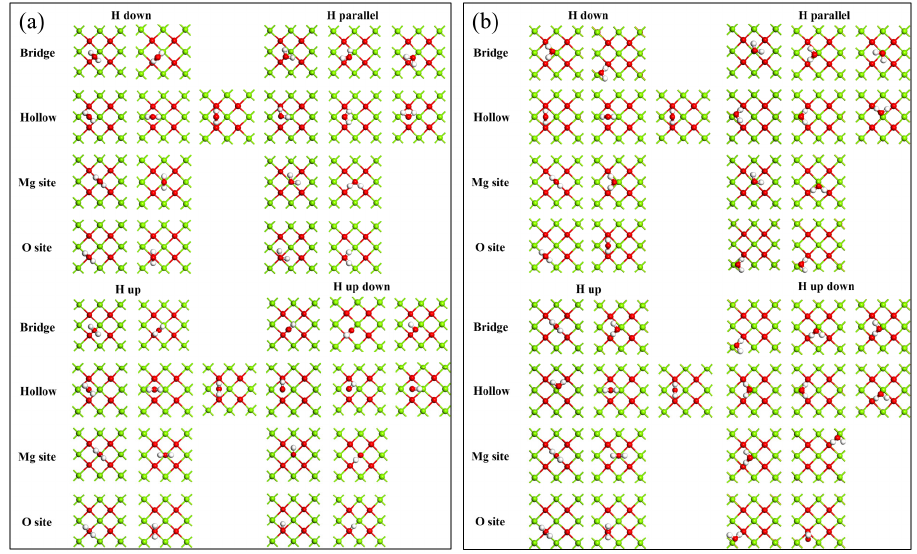
Figure 3. Adsorption models before and after adsorption of monomolecular water on MgO (100) plane: ( a ) before adsorption; ( b ) after adsorption. Table 2. Structural parameters and adsorption energy of monomolecular water adsorbed on MgO (100) plane with different orientations.